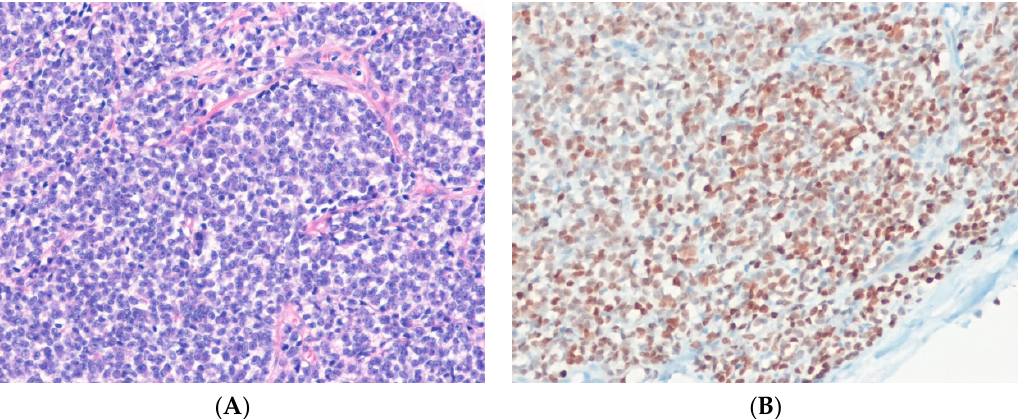
Figure 8. Ewing sarcoma. ( A ) The tumor shows round cells with fi nely granular chromatin and clear cytoplasm (H&E stain, ×100). ( B ) The tumor cells show di ff use nuclear staining for NKX2-2, sug- gesting the presence of underlying NKX2 - 2 upregulation as a downstream target of the EWSR1 :: FLI1 fusion gene (immunohistochemical stain for NKX2-2,